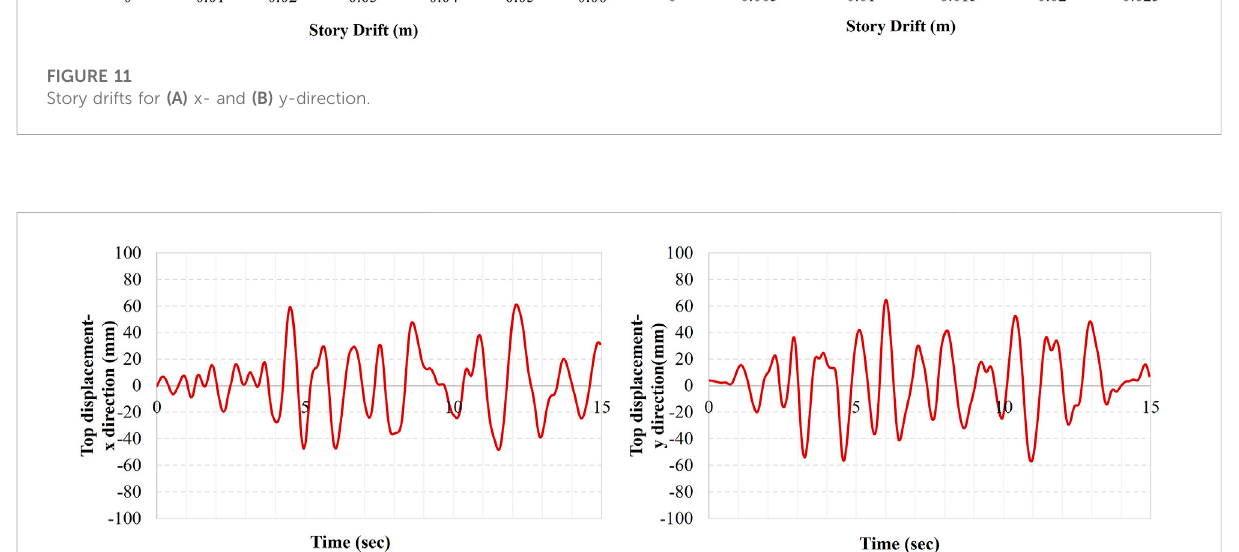
FIGURE 12 Top displacement – time traces in x- and y-direction for the Chuetsu Oki (Japan)